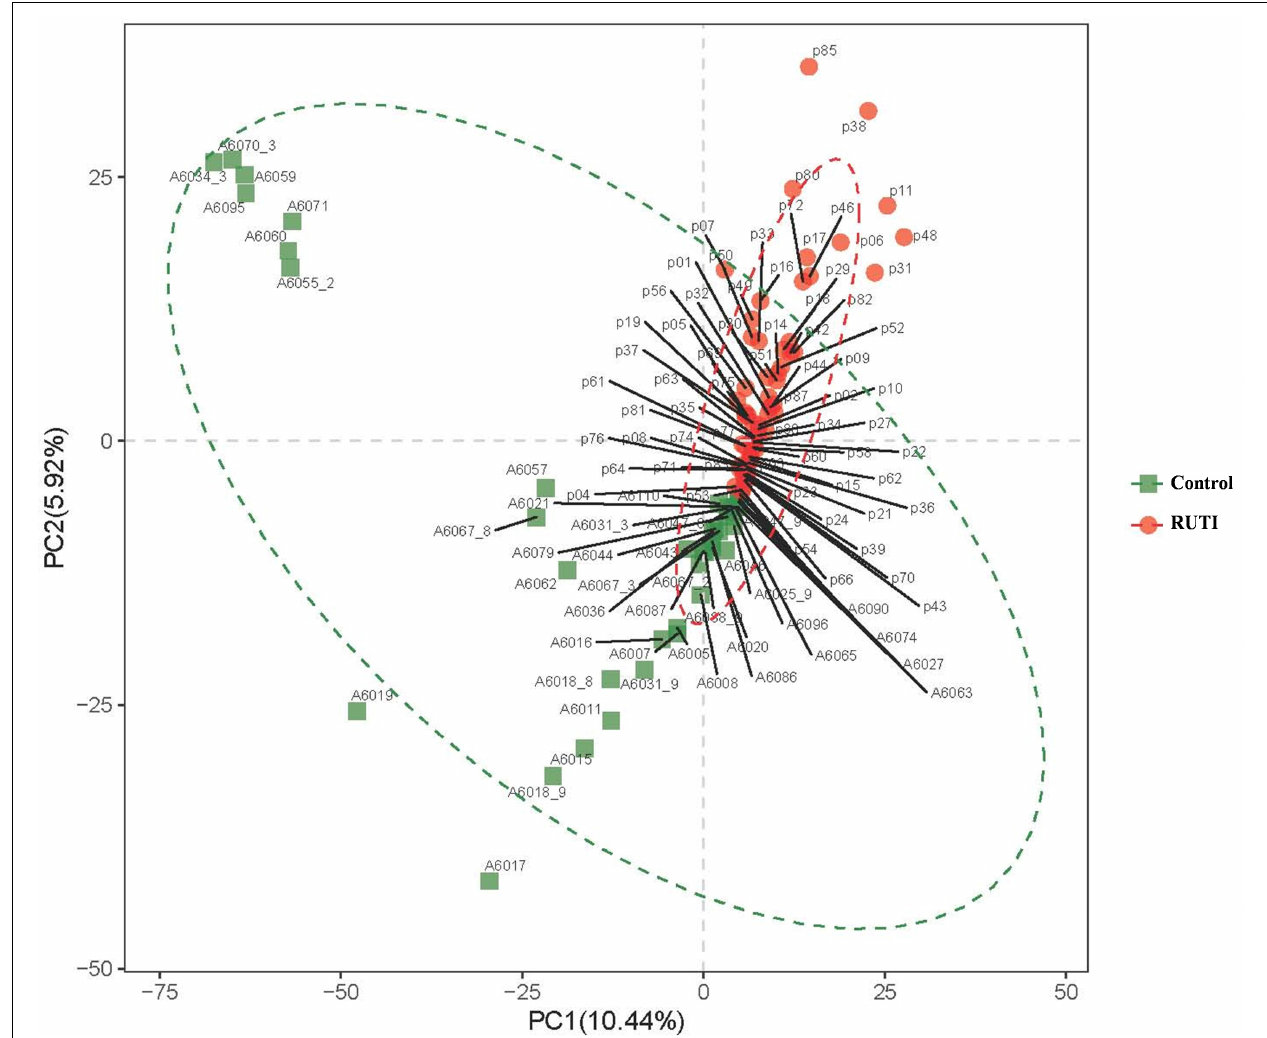
FIGURE 4 | Beta-diversity indices revealed by Partial Least Squares Discrimination Analysis (PLS-DA), ANOSIM, R = 0.209, P = 0.001. PC1 and PC2 in the X/Y-axes represented the two principal dimensions that can reflect the largest variance.